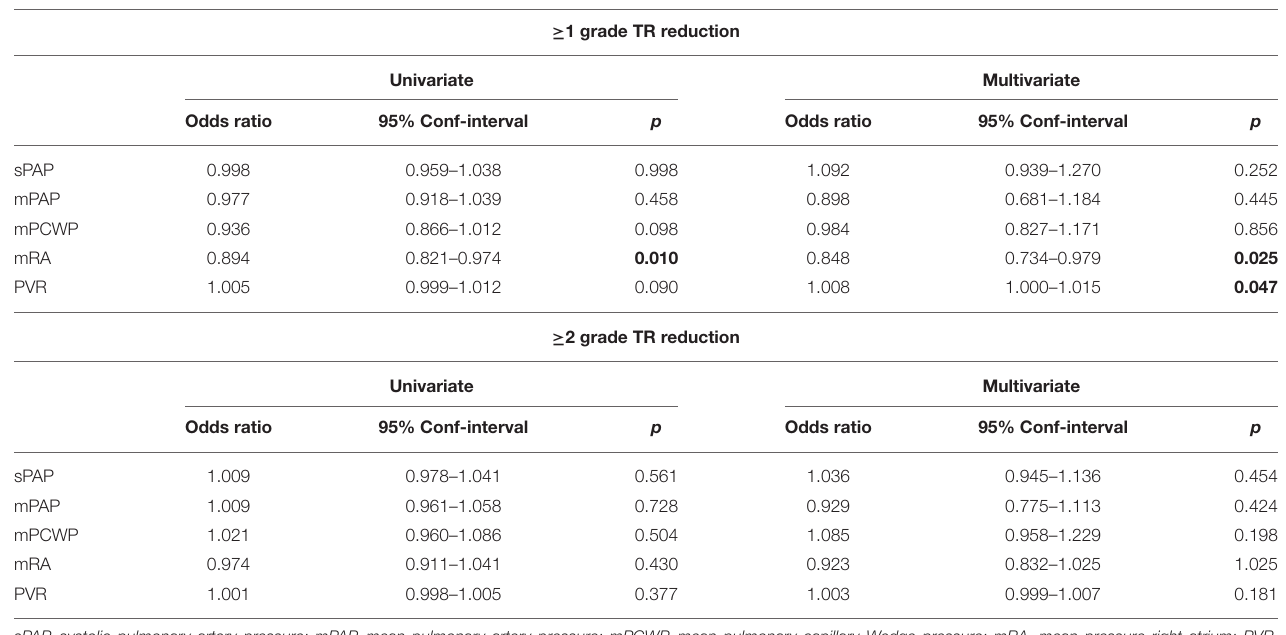
TABLE 3 | Logistic regression analysis for ≥ 1 and ≥ 2 grade TR reduction after TTVR and invasive hemodynamic